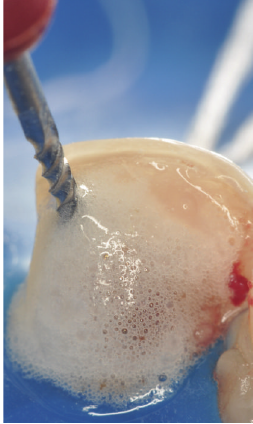
Figure 5: Chemical-mechanical preparation using K-flex file with endo-PTC (ASFER, Chemical Ind, S˜ao Caetano do Sul, SP, Brazil) and NaClO 1%.